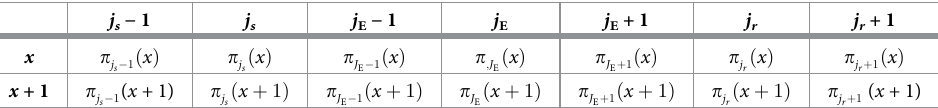
Focusing to the left side of the ECOFF ( j < J component; the sign function implies a single OR for all susceptible categories, and the identity Table 1. The 2 × 2 tables of interest, to the left and to the right of the ECOFF, with notation π j ( x ) = P ( y = j | x